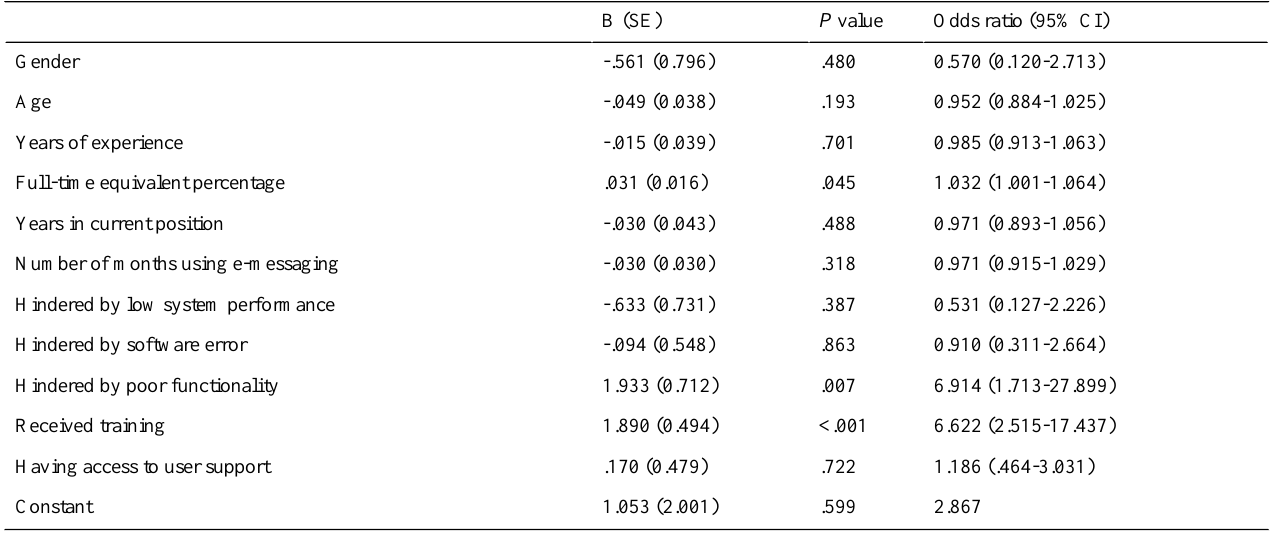
Table 4. Logistic regression model examining predictors affecting assessments of e-messaging as easy to use